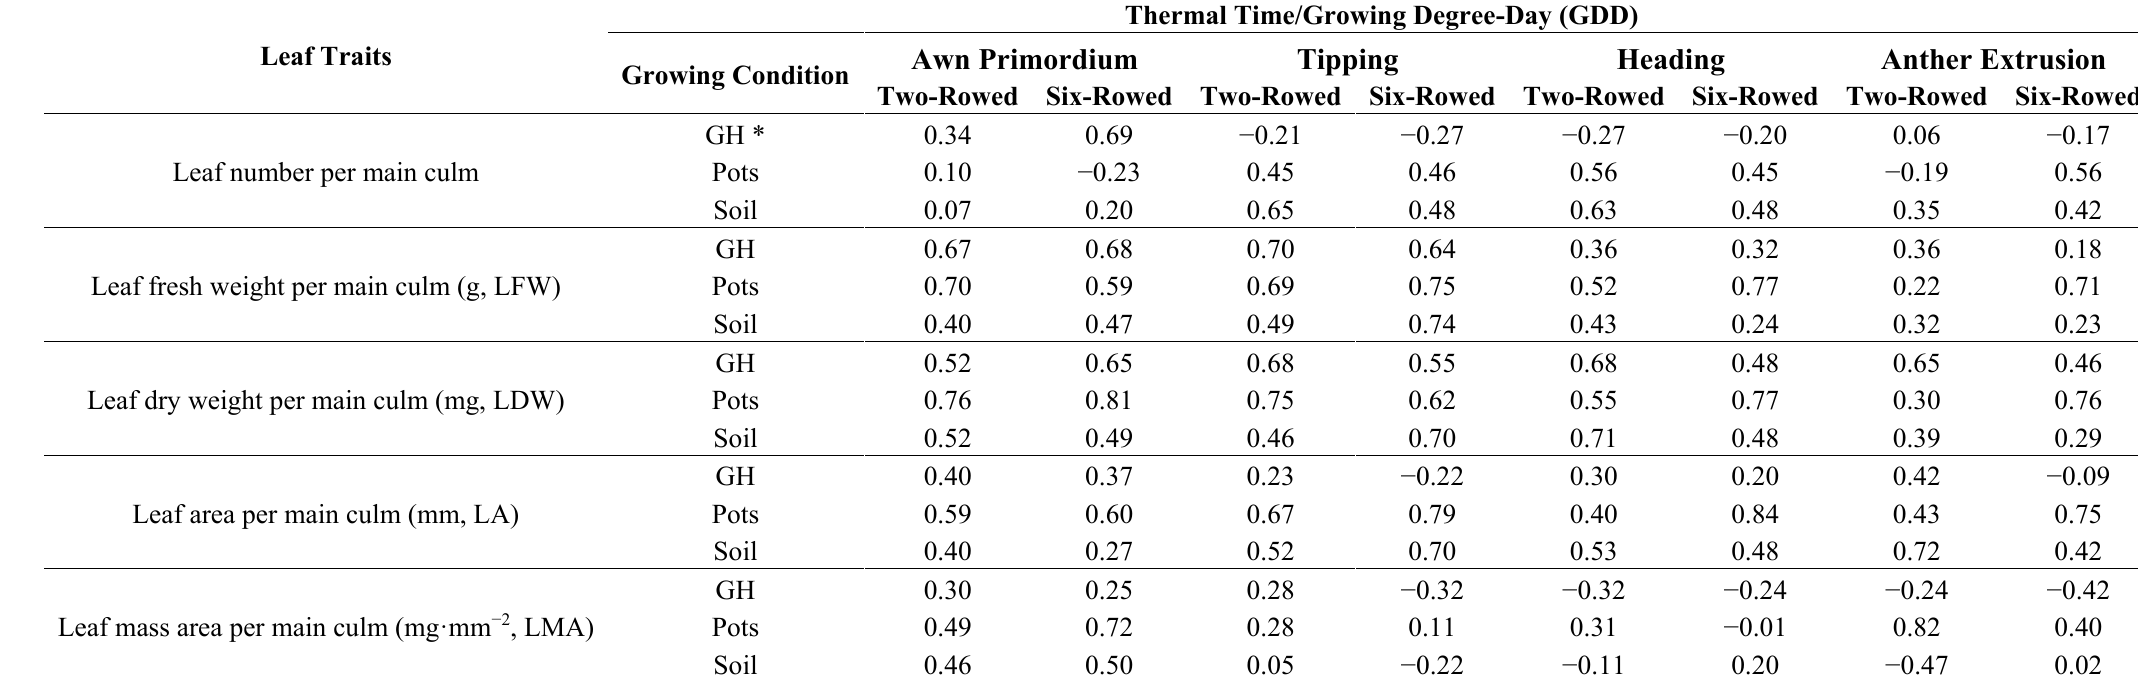
Table 1. Correlation coefficients between thermal times (GDD) at different stages with leaf traits. Leaf Traits Tipping Heading Anther